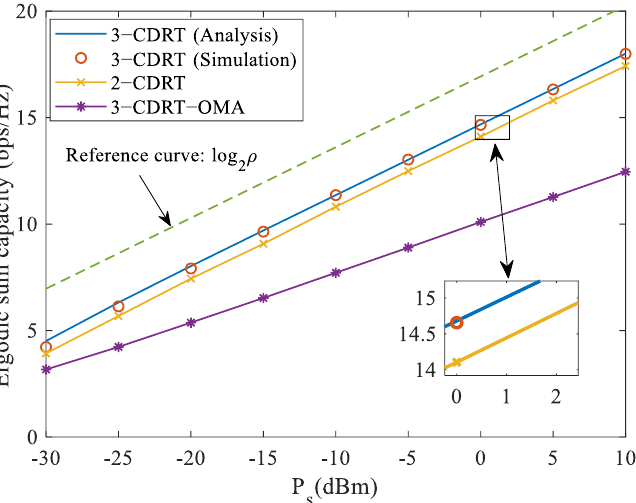
Figure 2. Comparison among the proposed 3 − CDRT strategy, the 2 − CDRT strategy and the 3 − CDRT − OMA strategy in terms of the ergodic sum capacity with varying P s (dBm).